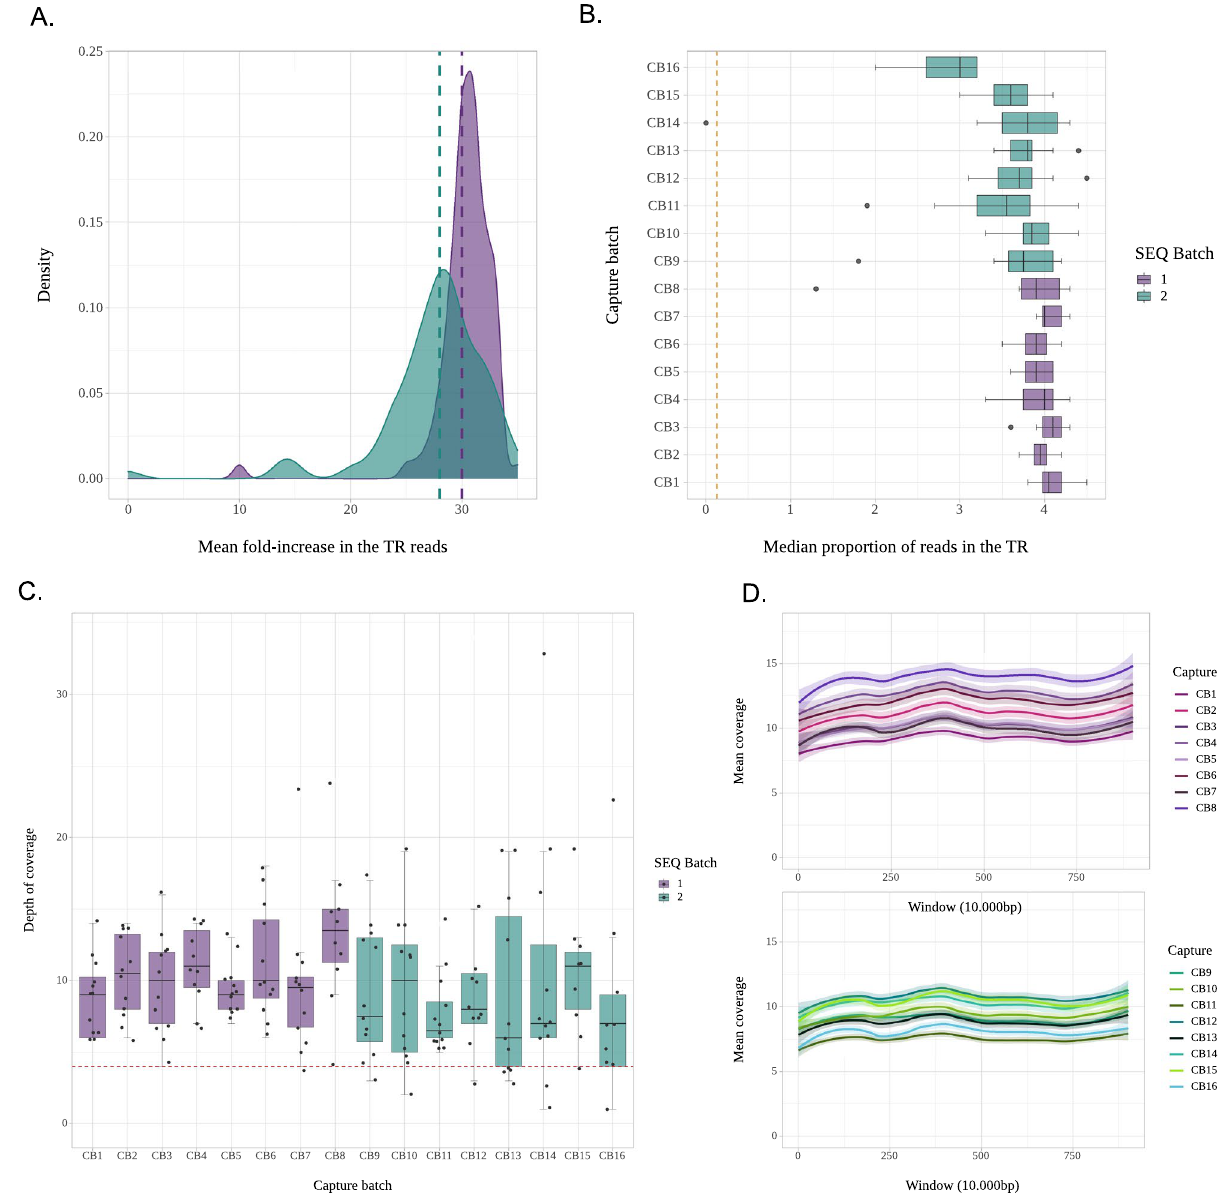
Figure 1. Parameters of capture performance. ( A ) Distribution of the mean fold- increase in the proportion of reliable reads in the Target Region per sequencing batch. The vertical lines correspond to mean values. ( B ) The median proportion of reliable reads in the Target Region per capture batch. The brown line corresponds to this proportion in one non-enriched sample. ( C ) Median depth of coverage in the Target Region for each capture batch and 95% confidence intervals. ( D ). Distribution of mean coverage across 902 genomic windows in the target region by sequencing